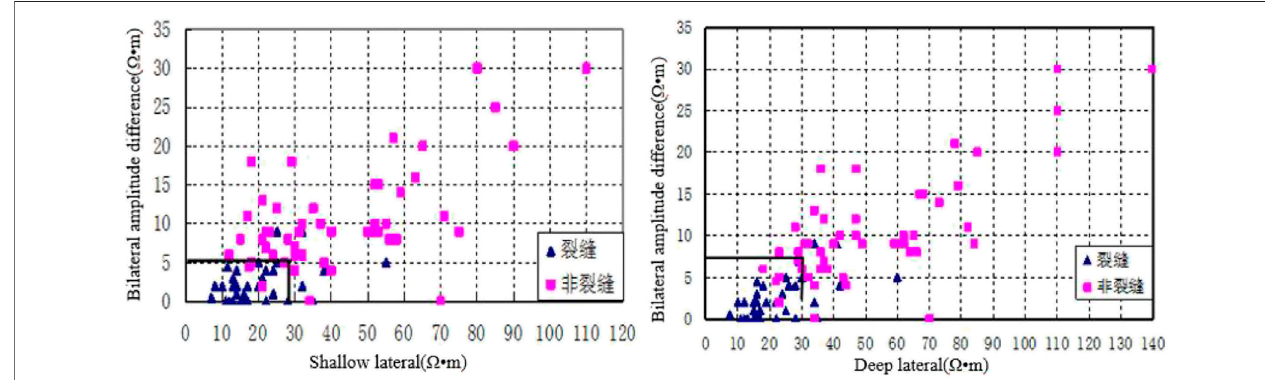
FIGURE 6 | Shallow deep lateral and bilateral lateral amplitude difference intersection chart.